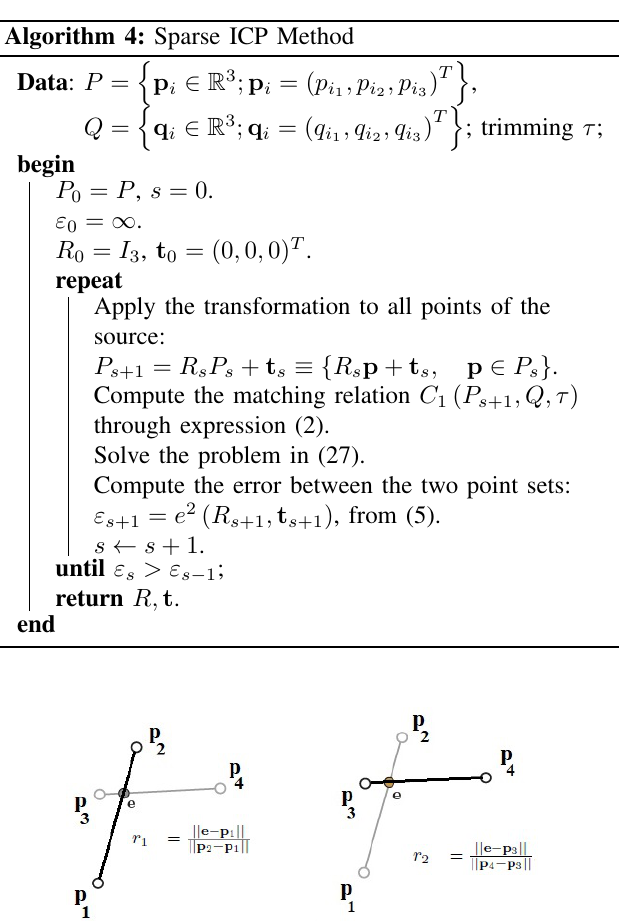
Fig. 2: Four coplanar intersecting in e and affine invariant ratios r 1 and r 2 (source [33]).